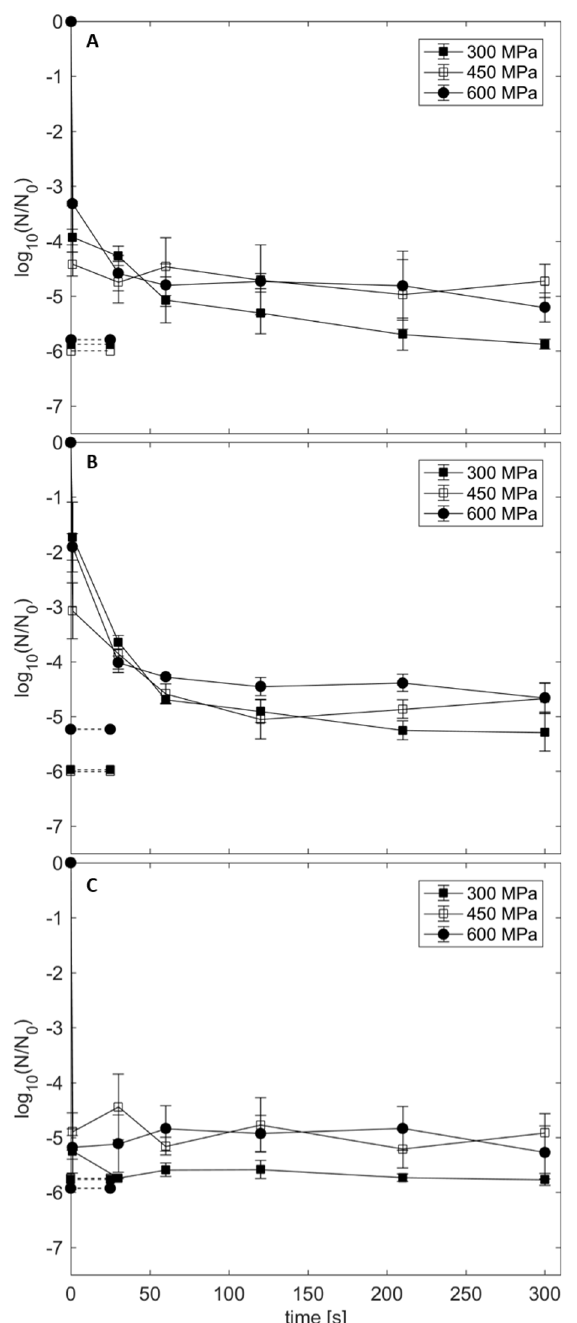
Fig 3. Log reduction of C. botulinum TMW 2.357 spores in green peas with ham. Target pressure levels of 300 MPa (solid square), 450 MPa (open square) and 600 MPa (solidcircle) in combination with process temperatures of 100˚C (A), 110˚C (B) and 120˚C (C) were appliedfor 1–300 s. Dashedlines indicate the corresponding detectionlimits. Initial spore count: 10 7 –10 8 spores/g. Data are shown as means ± standard deviations of triplicate